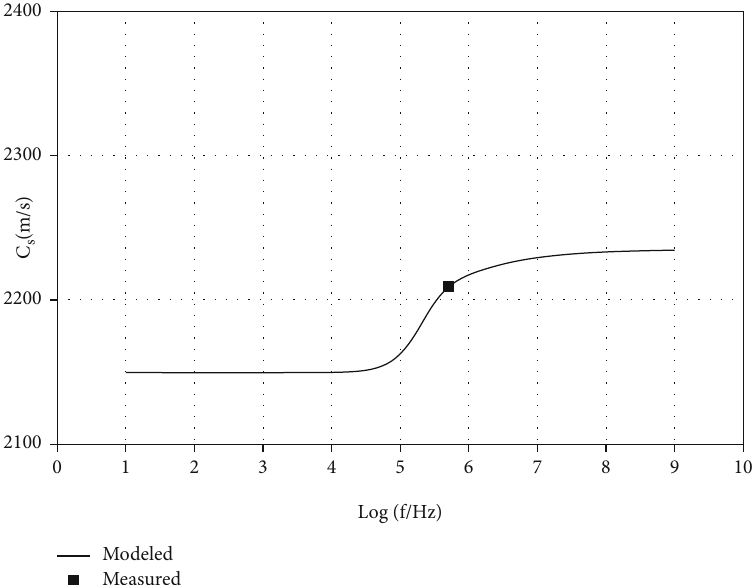
’ Euville limestone under